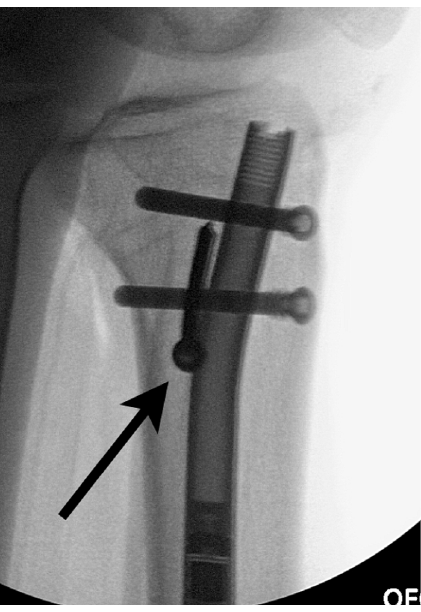
Figure 14. In this unrelated case, the proximal syndesmotic screw also served as the posterior blocking screw